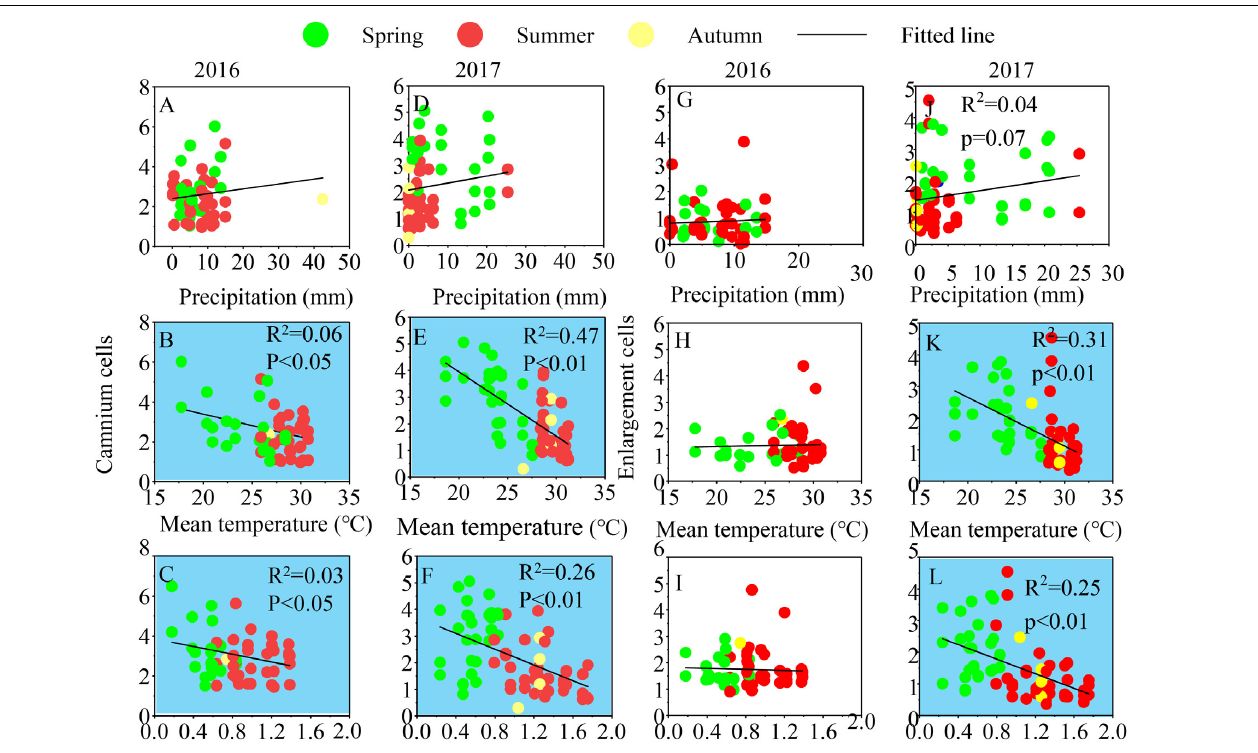
FIGURE 6 | Relationships between climate variables and the number of cells in cambium (A–F) and enlargement (G–L) of Cunninghamia lanceolata 2016–2017. Significant correlations ( p < 0.05) were shaded red (positive) and blue (negative).